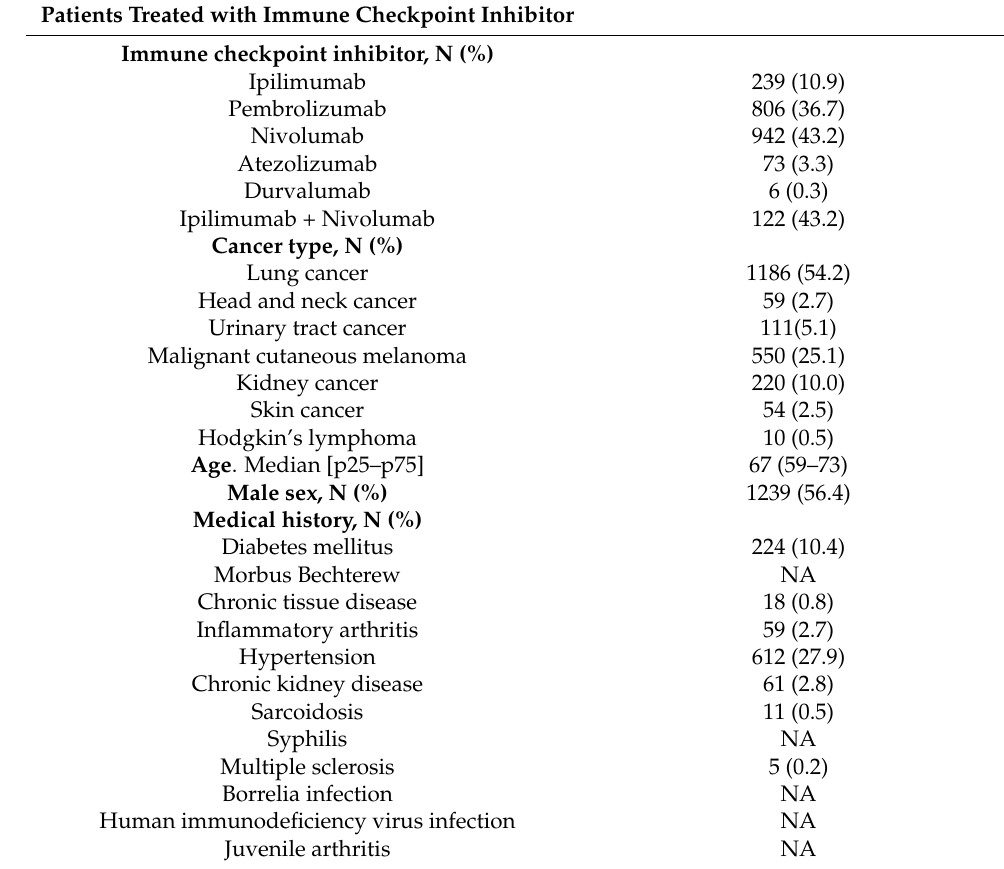
Table 2. Characteristics for patients treated with immune checkpoint inhibitors at first administration.